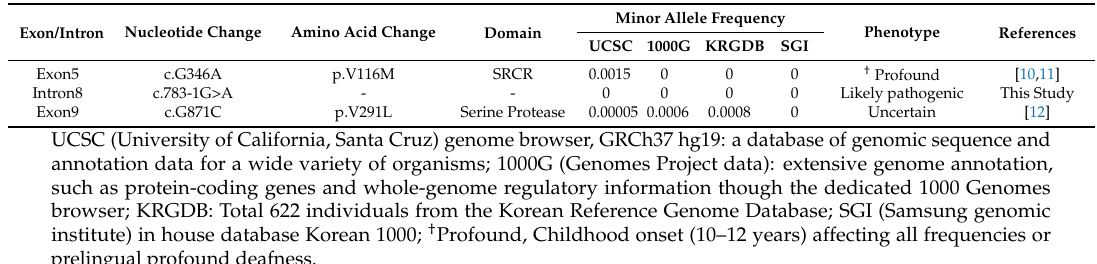
Table 2. Overview of the three variants in TMPRSS3 .